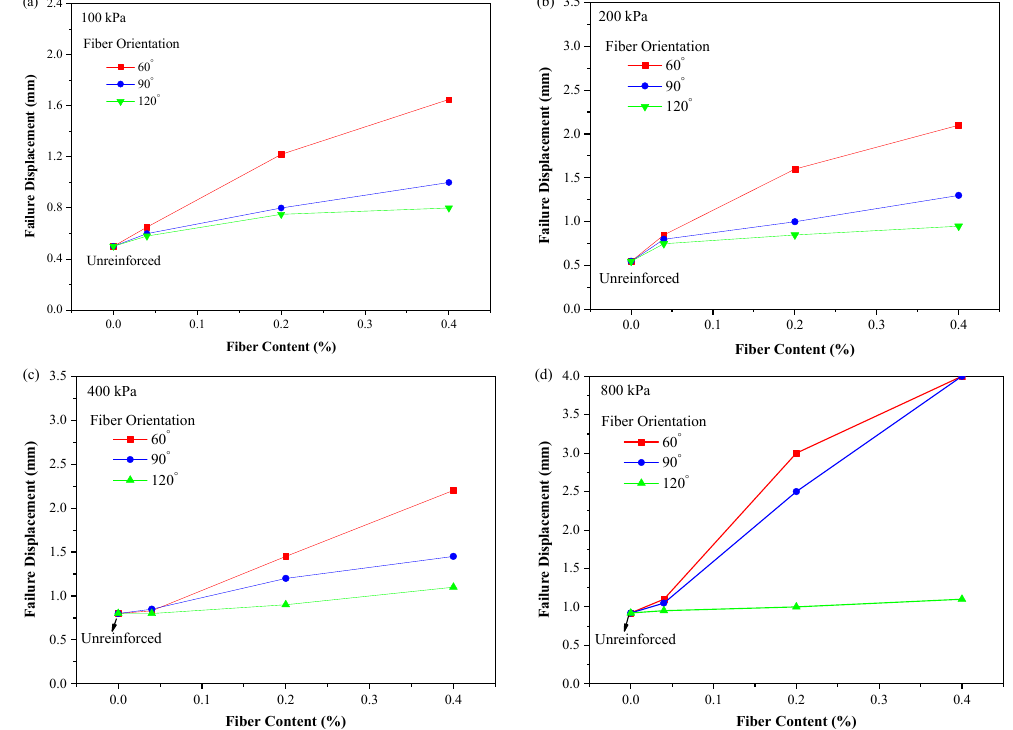
Figure 8. Failure displacement versus fiber content of sand specimens under normal pressures of ( a ) 100, ( b ) 200, ( c ) 400, and ( d ) 800 kPa.